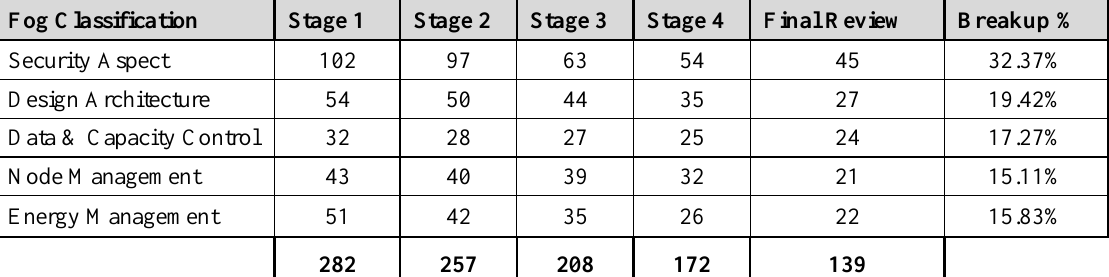
Table 1. Fog Computing Literature